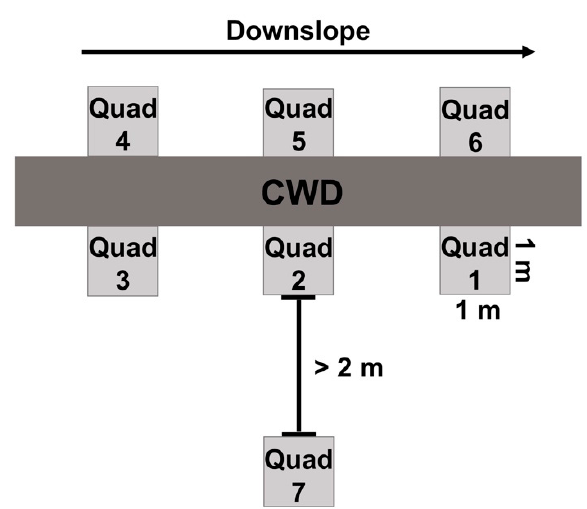
Figure 2. Representation of 1 m 2 quadrat establishment around each piece of coarse woody debris (CWD). Quadrat 7 was established colinear to Quadrat 2, and at least 2 m away from the focal piece of CWD and any other CWD.